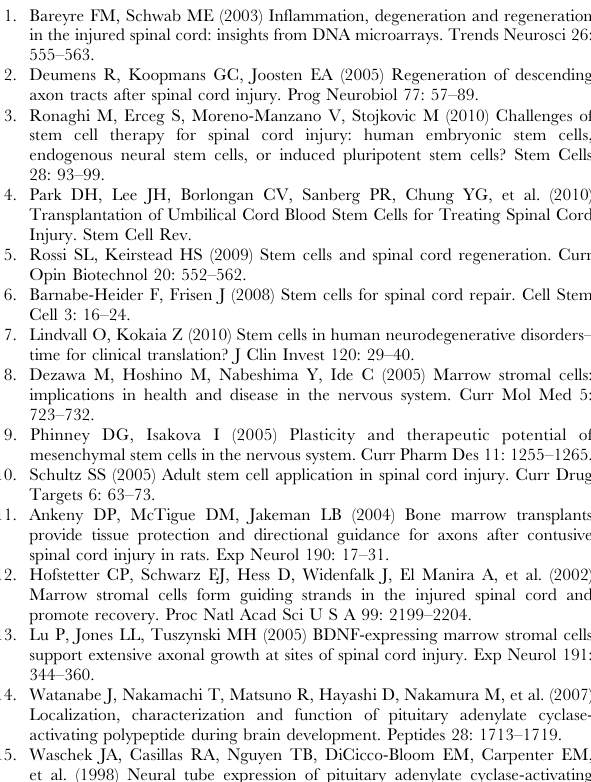
Figure S1 Separation of proteins from the lesion center of vehicle-treated injured spinal cord by 2-DE. The spinal cord tissues were dissected from the lesion center at 1 week after transplantation, and digested in the detergent containing lysis buffer consisting of 40 mM Tris, 40 mM sodium acetate, 1% NP- 40, 1% Triton X-100, 0.1% SDS, 1 mM PMSF, and protease inhibitor cocktail in PBS for 30 min, followed by sonication. Total proteins (200 m g) of the soluble fractions were separated by 2-DE and subjected to MALDI-TOF analysis. Total 142 proteins were identified through MALDI-TOF mass spectrometry and subse- quent database